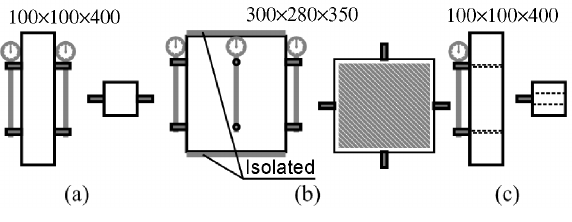
Fig. 2. Specimens for measuring the shrinkage deforma-